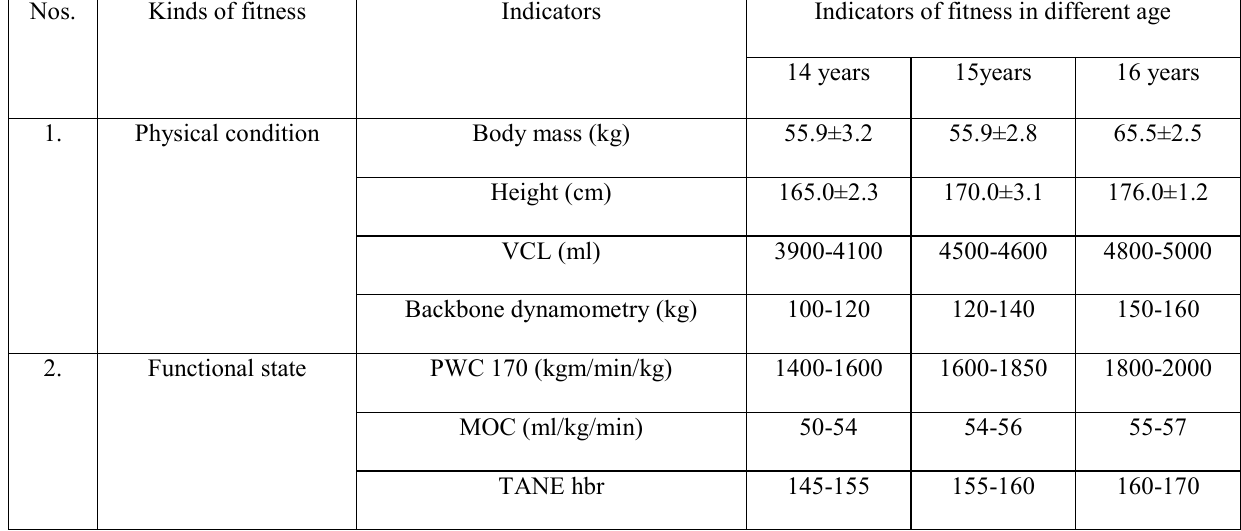
Indicators of physical condition and functional state of 14-16 years old junior football